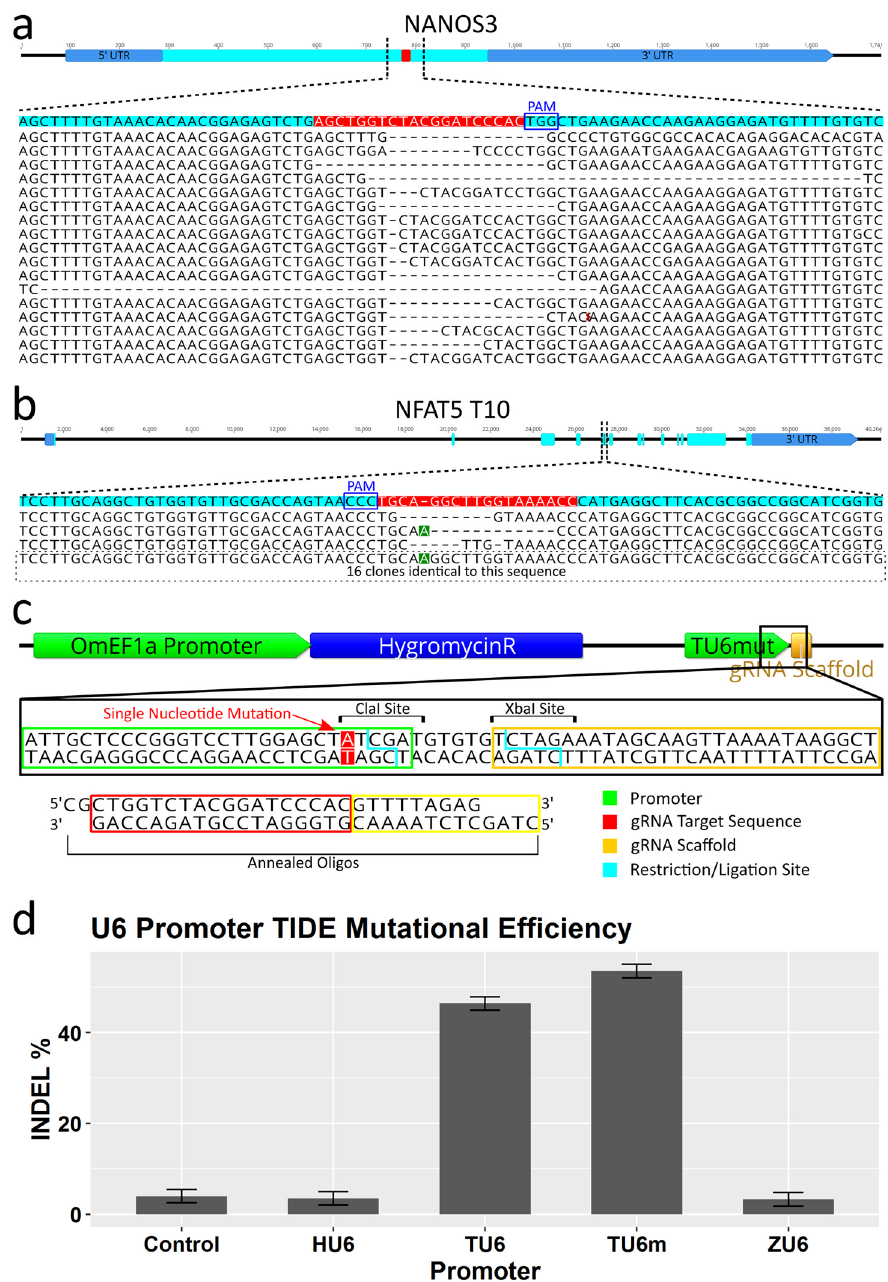
Figure 6. CRISPR/Cas9 editing confirmation and efficiency comparisons of different U6 promoters by analysis of NANOS3 gRNA target. ( a and b ) Sequencing results of individual alleles from plasmid sub-cloned test amplicons. ( a ) For the NANOS3 target, 17 out of 21 amplicons (81%) were altered at the target site (4 wild-type sequences not shown). ( b ) For the NFAT5 T10 target, 3 out of 19 amplicons (16%) were altered at the target site. The remaining 16 sequences were identical to the O. niloticus reference sequence except for an extra nucleotide (an A when reading the gene sequence 5 ′ to 3 ′ , a T when reading the gRNA sequence 5 ′ to 3 ′ ) 5 base pairs from the PAM sequence (highlighted in green). ( c ) Alternate cloning strategy for changing gRNA target sequence in expression vector illustrated. Utilizes a mutated TU6 (TU6m) in which a single nucleotide was changed adjacent to the TSS generating a ClaI restriction site. The TU6m is included in the base vector in which new gRNA target sequences can be added by annealed oligos. ( d ) Mutational efficiency quantified by TIDE indel% analysis of four different U6 promoters using the same gRNA target ( NANOS3 ) showing superior editing obtained from both versions of the tilapia U6 promoters (over fivefold over all others). The Human and Zebrafish U6 promoters were not statistically significant from the no U6 control. Gene maps and DNA sequence images were generated using Geneious 11.0.3 (Biomatters, https:// www. genei ous. com). Bar plot was generated using Rstudio version 1.1.456 (https:// rstud io. com). Image editing and assembly into complete figures was performed using Inkscape version 0.92 (https:// www. inksc ape.